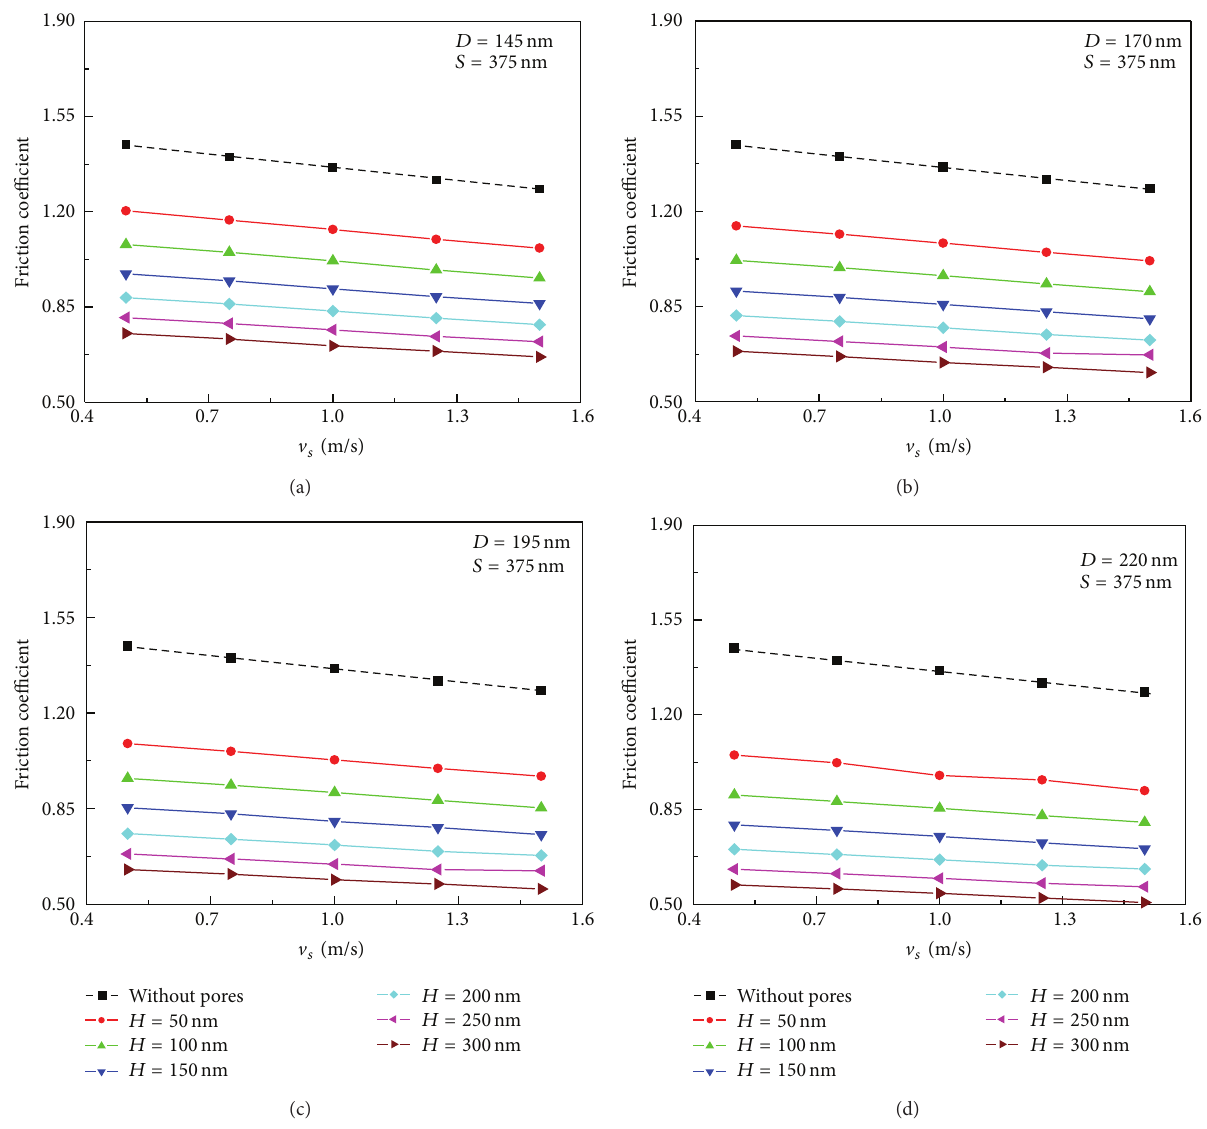
Figure 11: Friction coefficient at different speeds of Coscinodiscus sp. frustule: (a) at diameter of 145 nm, (b) at diameter of 170 nm, (c) at diameter of 195 nm, and (d) at diameter of 220